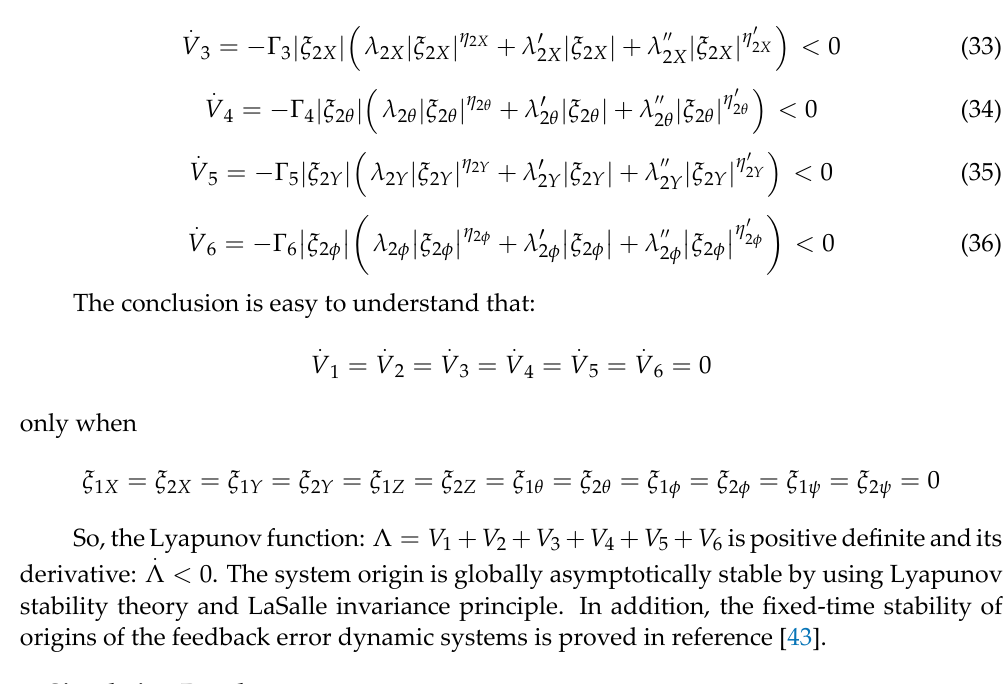
Figure 4. The curve of the disturbance in position Y channel.